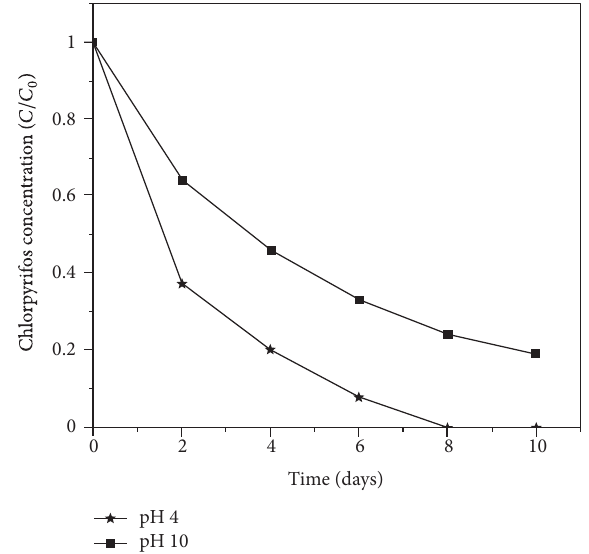
F 5: Time-course degradation of chlorpyrifos at different pH